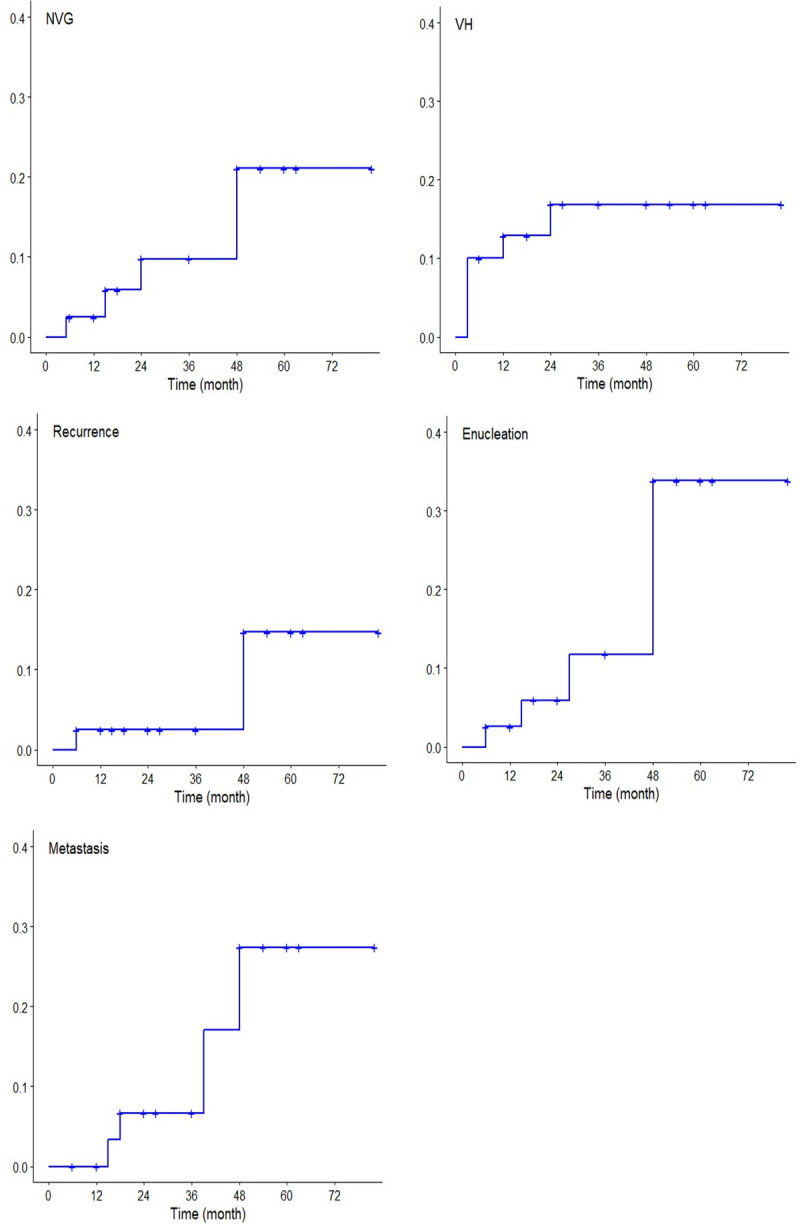
Kaplan-Meier Curve of ocular effects after Proton Beam Therapy for all choroidal melanoma patients.a) the cumulative incidence rate of neovascular glaucoma b) the cumulative incidence of vitreous hemorrhage c) the cumulative incidence of local recurrence d) the cumulative incidence of enucleation e) the cumulative incidence of distant metastasis.